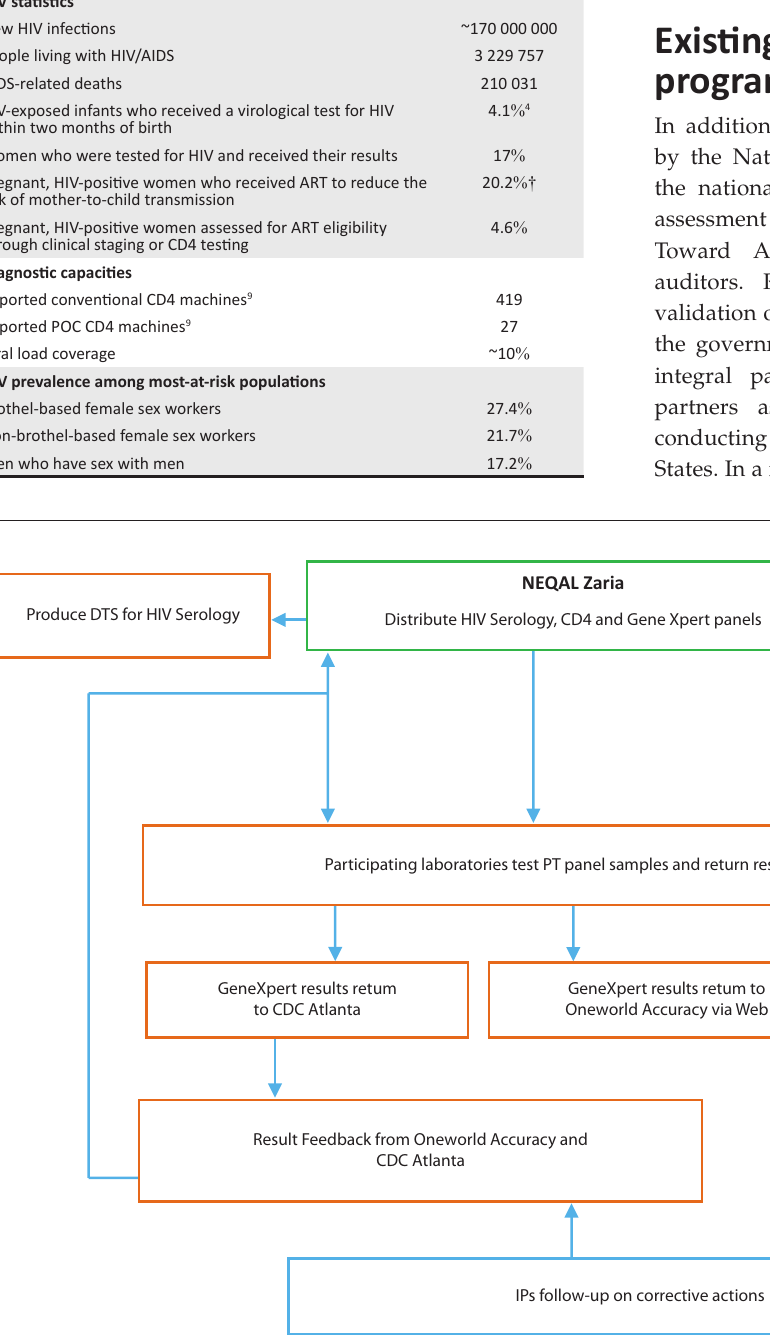
TABLE 1: Key characteristics of the HIV epidemic in Nigeria.